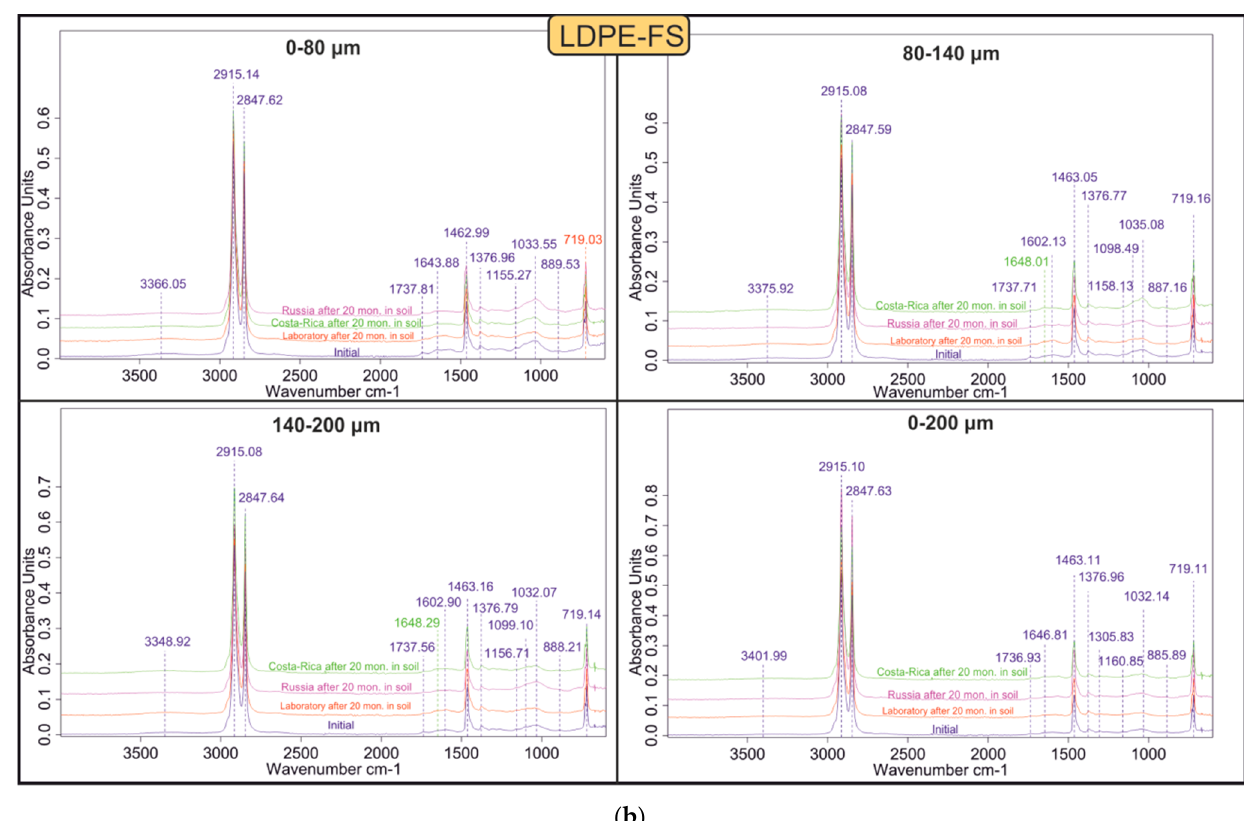
Figure 5. FTIR spectra of biocomposites with wood flour ( a ) and flax straw ( b ) according particle size used. Initial samples, samples after soil tests for 20 months in laboratory conditions, in Russia, and in Costa Rica.